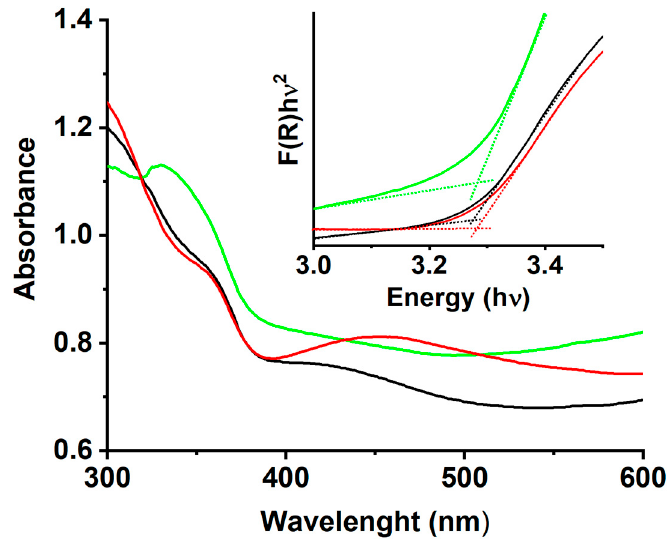
Figure 7. DR-UV spectra of bare TiO 2 nanotubes (black line), 5-NBC-TiO 2 (red line), and 5-MBC-TiO 2 (green line). Inset: Kubelka–Munk plots for the samples.